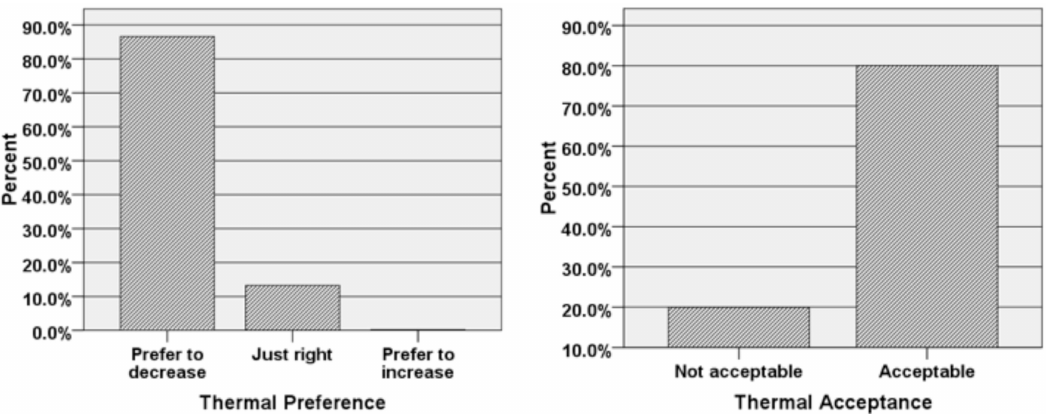
Figure 6. Respondents’ thermal preference ( left ) and thermal acceptance ( right ).